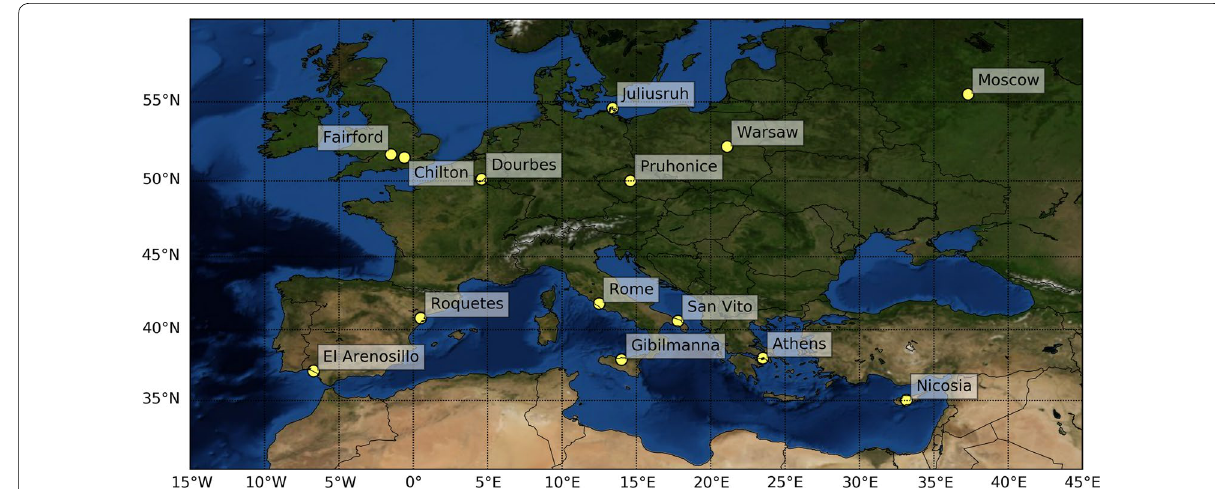
Fig. 1 European ionosonde network involved in the study. Geographical distribution of the ionospheric stations listed in Table